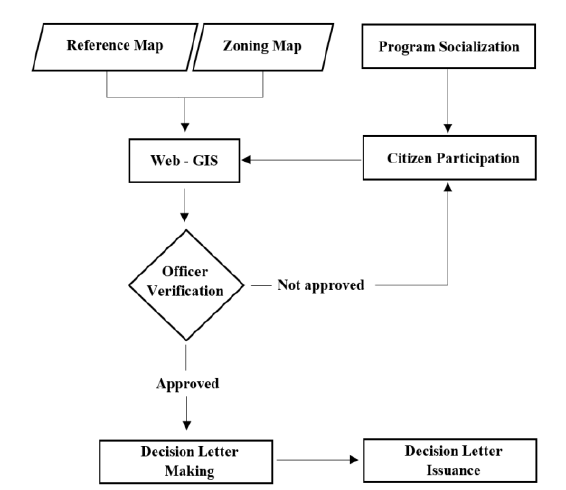
Figure 1 . Methodological framework of Priority Villages version 2.0